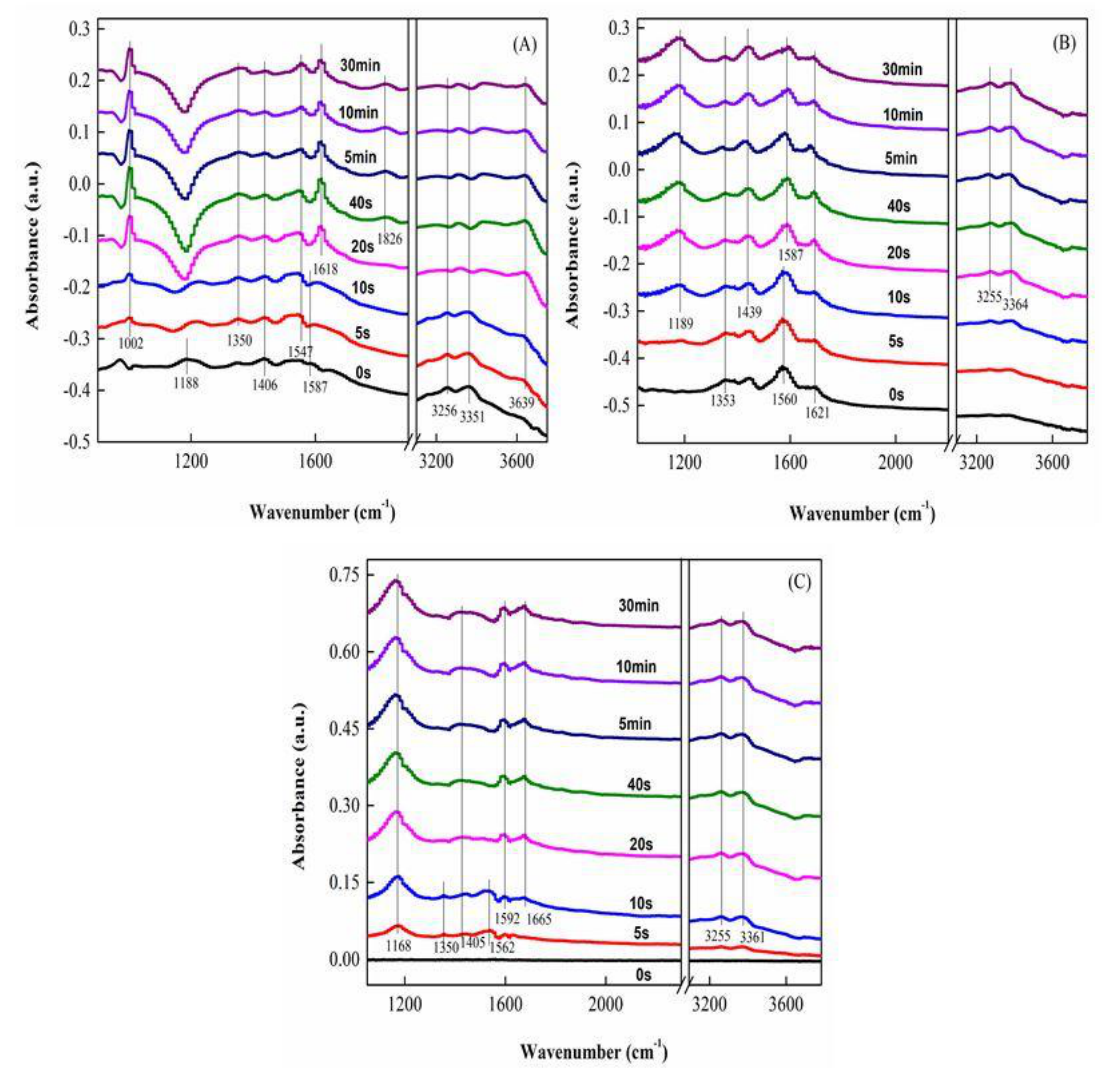
Figure 8. In situ diffuse reflectance infrared Fourier transform spectroscopy (DRIFTS) of Fe85Ce10W5–CP–CA catalyst under transient reactions at 250 °C. ( A ) Between nitrogen oxides and pre-adsorbed NH 3 species. ( B ) Between NH 3 and pre-adsorbed nitrogen oxides species. ( C ) The NH 3 , NO, and O 2 species.